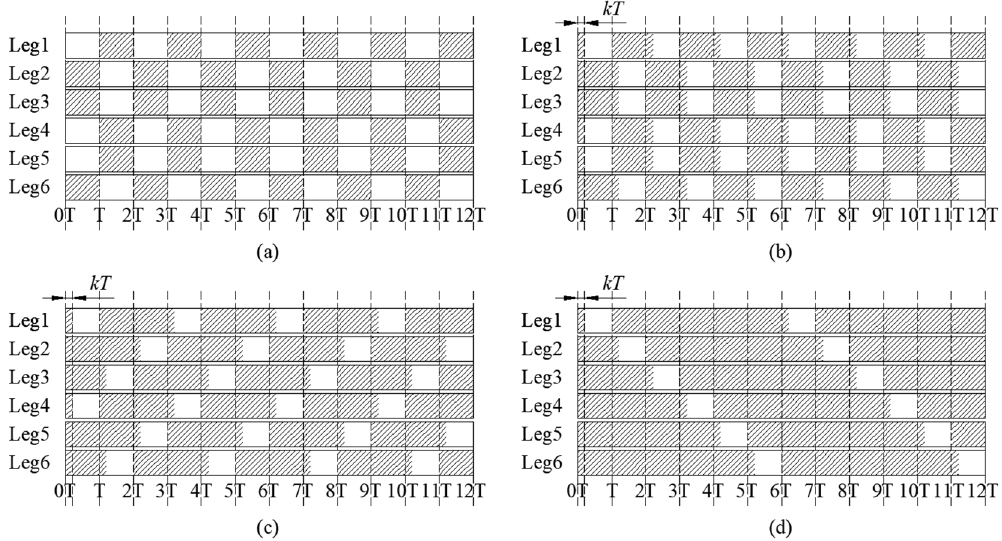
Figure 5. Time sequence diagram of the robot walking forward in tripod gait: ( a ) The general tripod gait; ( b ) The tripod gait with “increasing duty factor”; ( c ) The quadrangular gait with “increasing duty factor”; ( d ) The pentagonal gait with “increasing duty factor”.